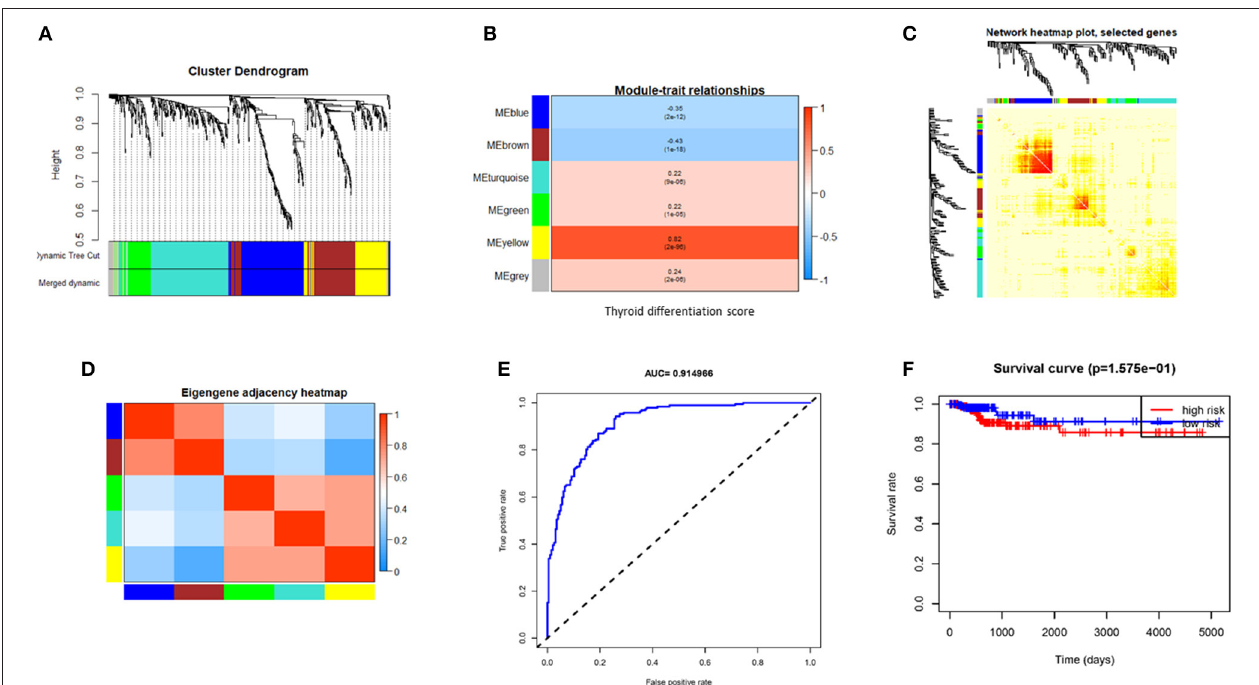
FIGURE 2 | Gene modules identified by weighted gene co-expression network analysis (WGCNA) and indicative ability of hub gene signature constructed by logistic regression for PTC differentiation and disease free survival rate. (A) Cluster the gene dendrograms according to topological overlap and assign different colors to each module. Finally, seven co-expression modules were constructed. The size of these modules varies according to the number of genes they contain. (B) Module–TDS associations. Each row corresponds to a module eigengene; each column corresponds to TDS. Each cell contains the corresponding correlation and p -value. (C) Using heat map plots to visualize gene networks. The heat map depicts the topological overlap matrix (TOM) between all genes in the analysis. (D) Heat map of module adjacency. Red indicates high adjacency (positive correlation), and blue indicates low adjacency (negative correlation). (E) The receiver operating characteristic (ROC) shows indicative ability of hub gene signature for TDS. (F) Hub gene signature fails to distinguish DFS well. PTC, papillary thyroid cancer; TDS, thyroid differentiation score; DFS, disease-free